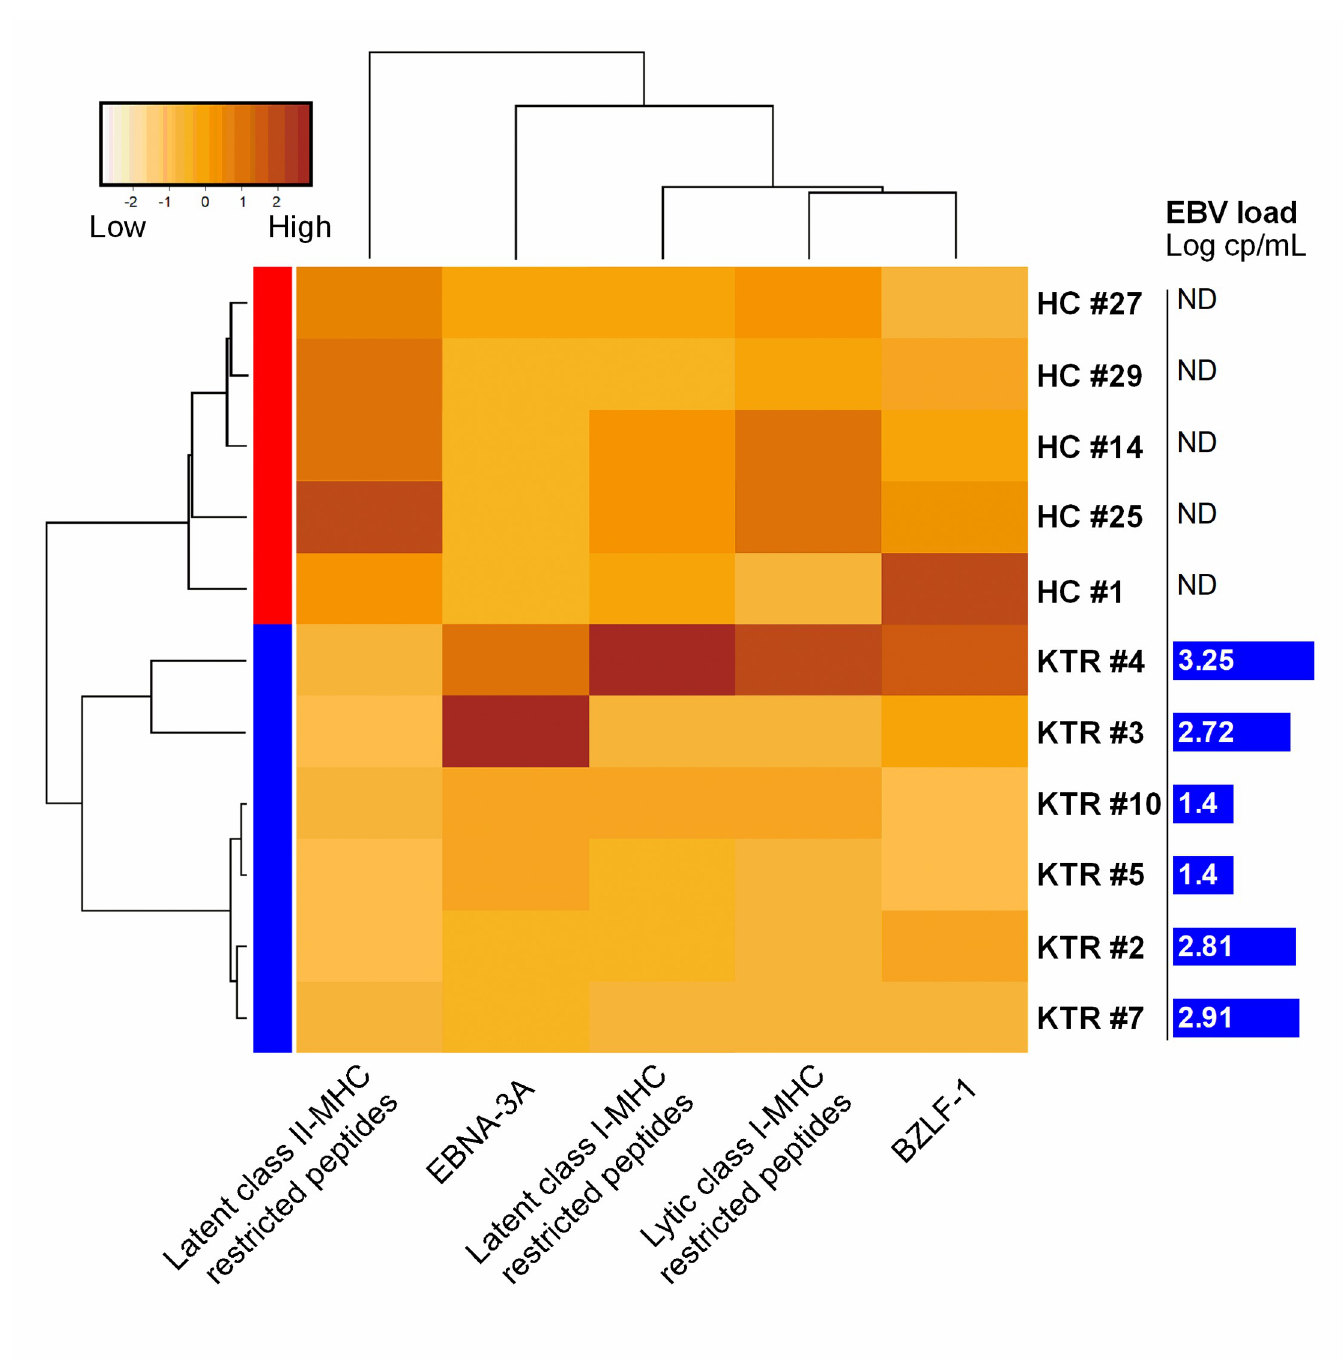
Fig 2. Hierarchical clustering of kidney transplant recipients (KTRs) and healthy controls (HCs) according to effector T cell responses. Heatmap plot of EBV- specific CD4 + Th1 and CD8 + effector T cell responses detected by ELISpot-IFN γ . Lines are individual KTRs (Blue) or HCs (Red). Columns are each peptide pool tested separately in ELISpot IFNg assay. Color scale represents the magnitude of the response expressed in spot forming cells (SFC)/10 6 PBMCs. Dendrograms were generated using unsupervised hierarchical clustering based on the Ward.D method. Last column to the right show the EBV load determined at simultaneous blood sample in Log